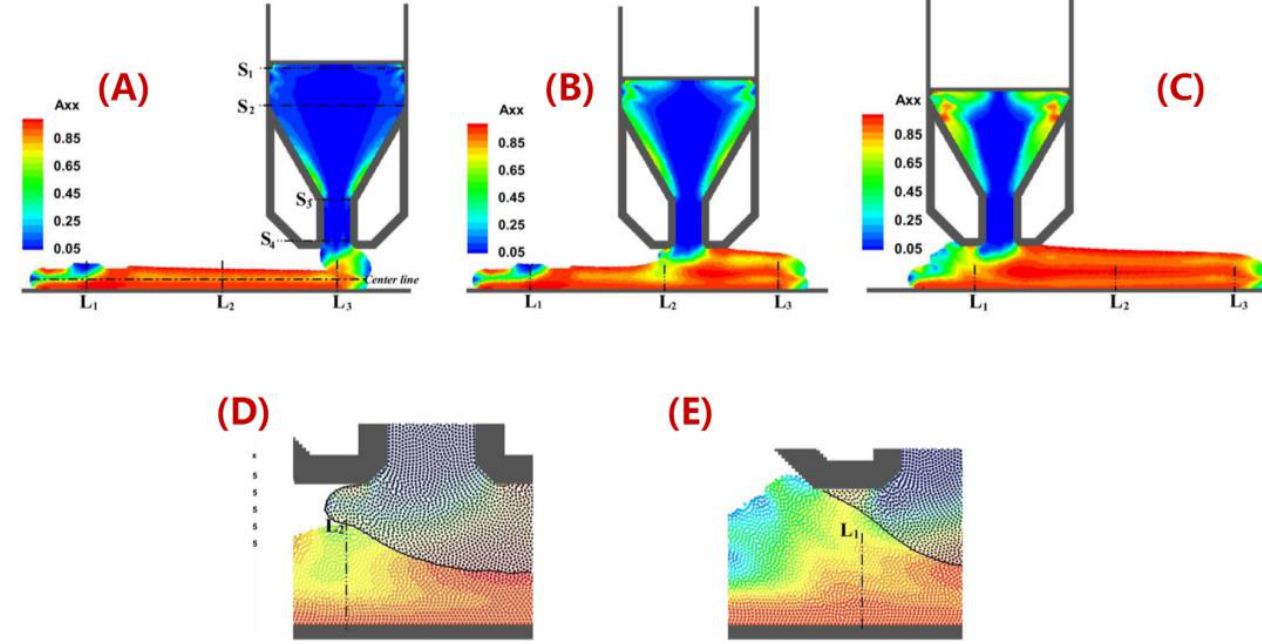
Figure 9. Instantaneous contour plots of the orientation tensor component Axx for the two-layer printing: ( A ) t = 0.12 s, ( B ) t = 0.15 s, and ( C ) t = 0.195 s. Here, ( D , E ) correspond to the enlargement of ( B , C ) in the regions L 1 and L 2 , respectively, where both layers are highlighted ( Φ = 0.03, a = 30) [119].